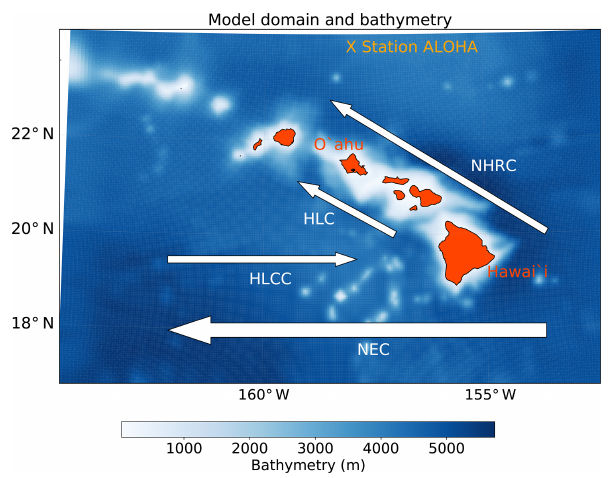
Figure 1. Model domain and bathymetry, with mean currents la- beled from Lumpkin and Flament